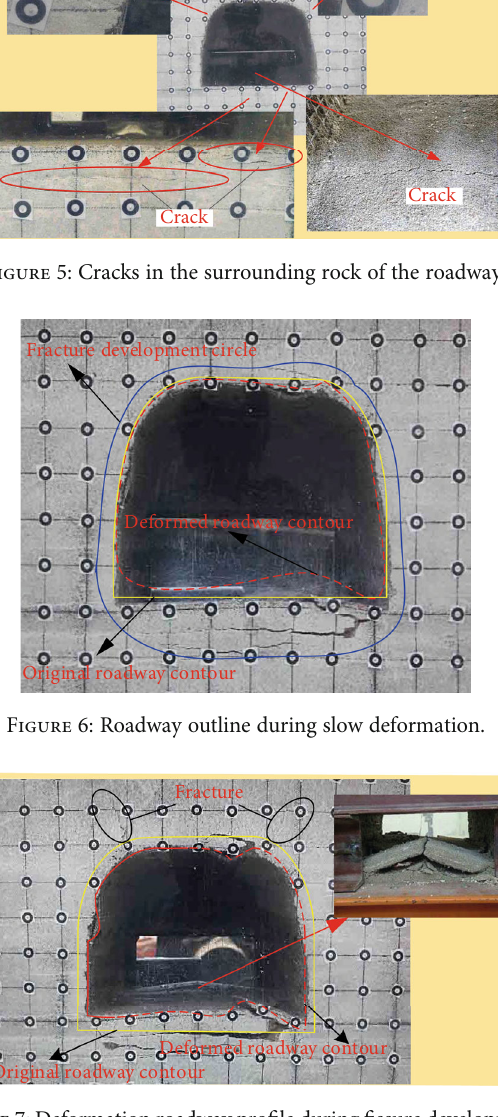
Figure 7: Deformation roadway pro fi le during fi ssure development.